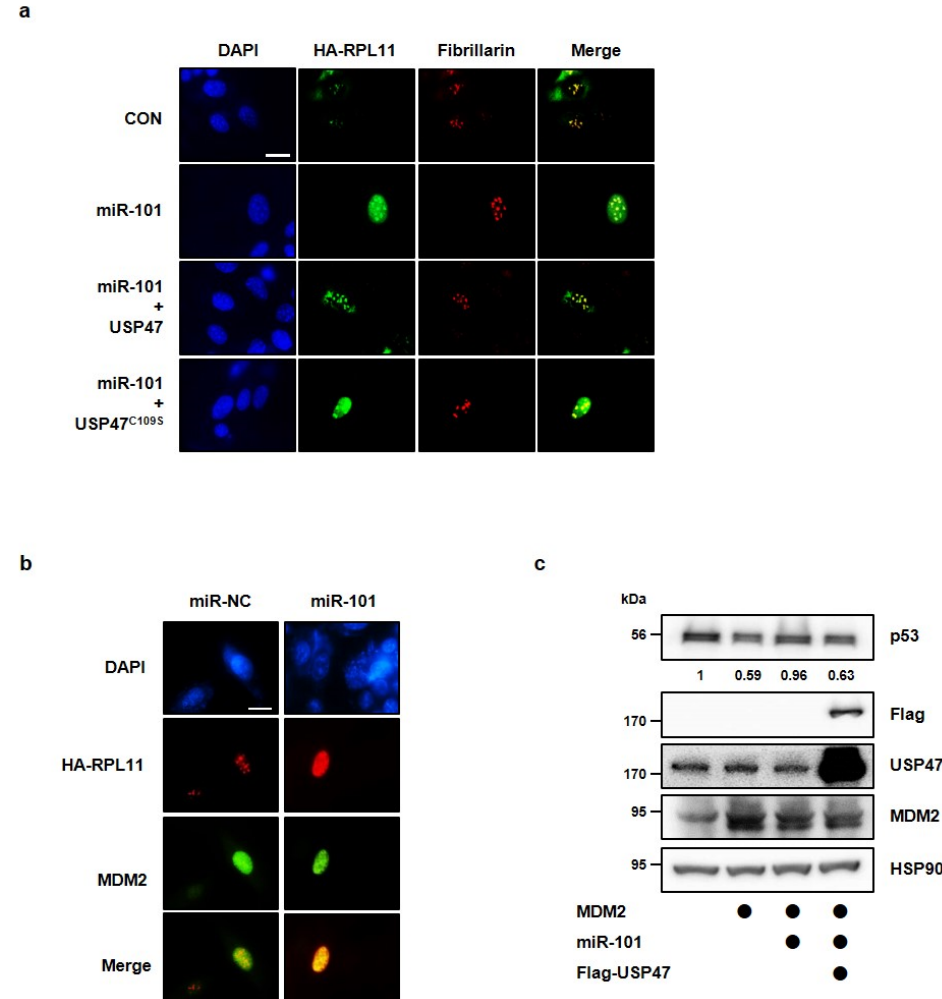
Figure 6. MiR-101-3p changes the localization of RPL11 by targeting USP47. ( a ) U2OS cells were transfected with HA-RPL11 alone or together with miR-101-3p mimic, Flag-USP47, or Flag-USP47C109S. Immunofluorescence staining was performed using an anti-HA antibody. The nucleoli were stained with an anti-fibrillarin antibody. Scale = 10 μ m. ( b ) U2OS cells were transfected with HA-RPL11 alone or together with a miR-101-3p mimic. Immunofluorescence staining was performed using the anti-HA antibody and anti-MDM2-antibody. Scale = 10 μ m. ( c ) A549 cells were transfected with MDM2 alone, or together with Flag-USP47 or a miR-101-3p mimic. Western blot analysis was performed to detect the p53 protein